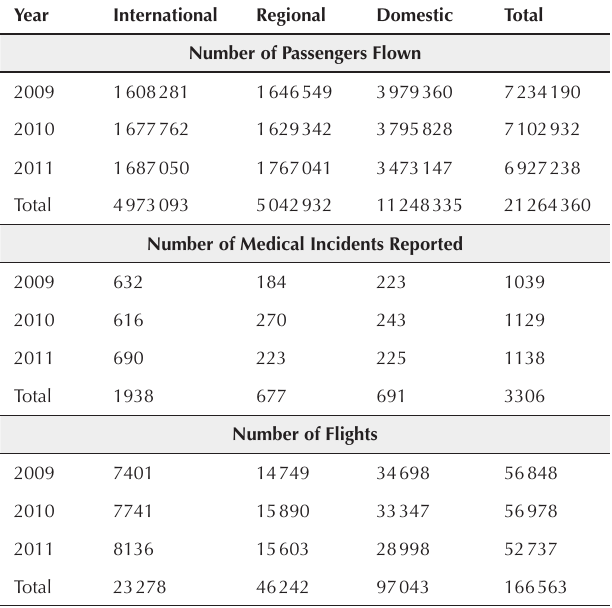
Table 2. Frequency Table of Nature of Medical Events Recorded Between 2009 and 2011 Nature of Medical